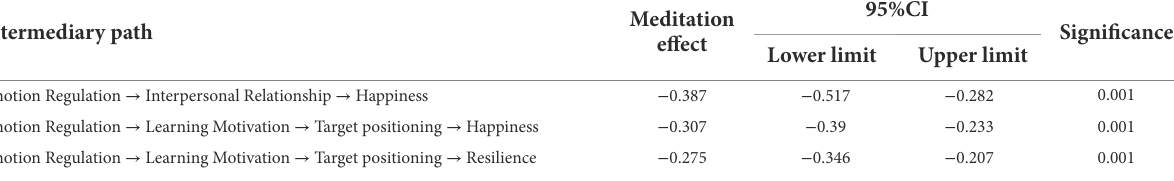
TABLE 6 Analysis of the mediating effect between relationship, emotion regulation, happiness, resilience, and learning motivation.